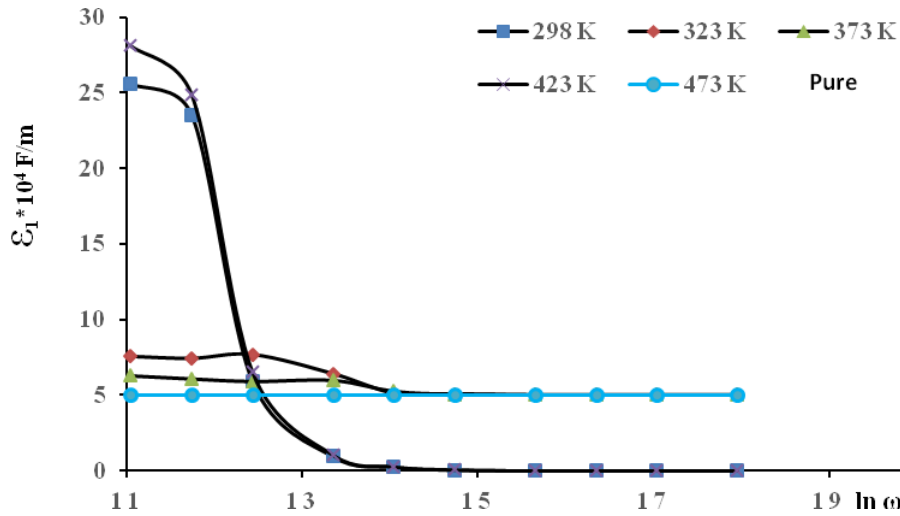
Fig. 4: The variation of (ε ) with ln(ω) for pure ZnS films treated at different temperatures. 1